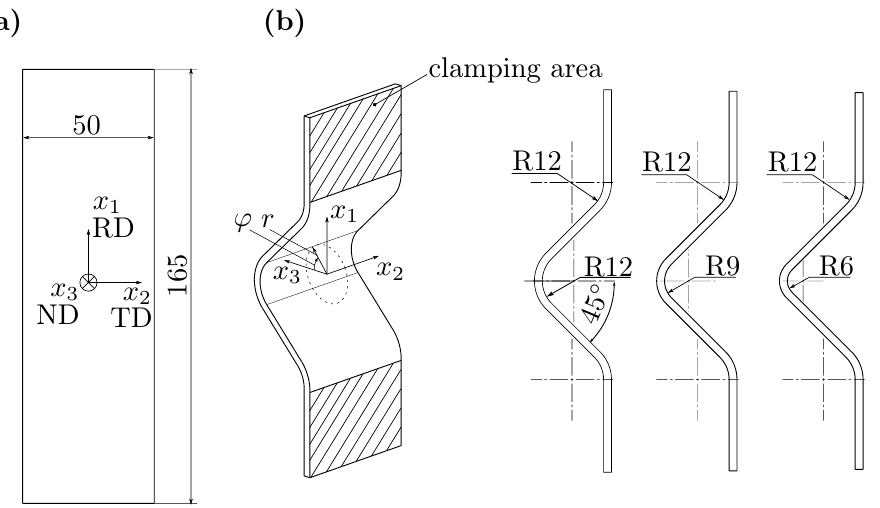
Figure 1. Variations of the structural component specimen: ( a ) blank of the structural component specimen with a global ( x 1 , x 2 , x 3 ) -coordinate system; ( b ) the investigated versions of the structural component with a cylindrical coordinate system ( r , ϕ , x 2 ) in the gauge area.